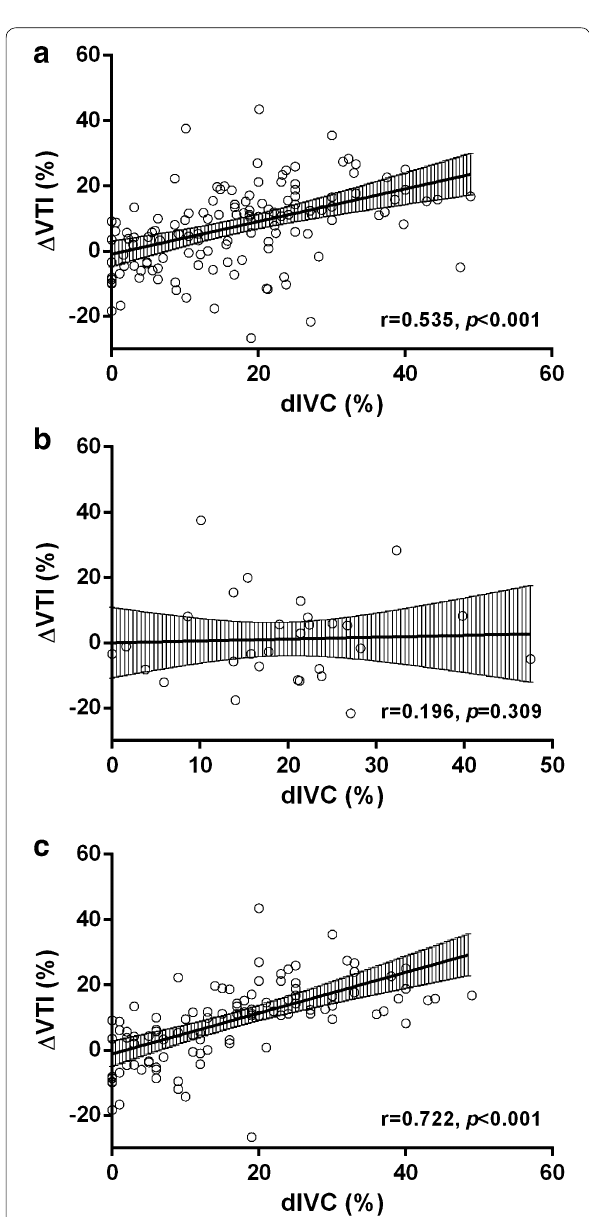
Fig. 3 Correlation of dIVC and △ VTI. a Correlation of dIVC and △ VTI in all patients, r 0.535, p < 0.001. b Correlation of dIVC and △ VTI = in ILVD patients, r 0.196, p 0.309. c Correlation of dIVC and △ VTI = = in NLVF patients, r 0.722, p < 0.001. Correlation of dIVC and △ VTI = derived from NLVF patients was strengthened than that derived from all patients, p 0.020. ILVD isolated left ventricular systolic = dysfunction, NLVF normal left ventricular function; dIVC inferior vena cava distensibility index, △ VTI velocity–time integral change after passive leg